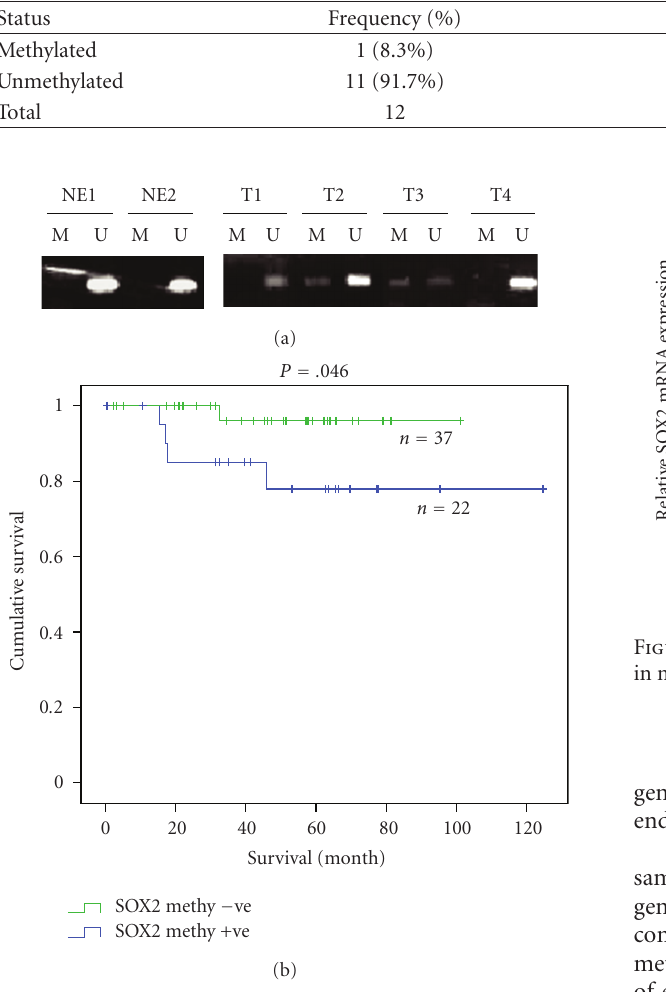
Figure 1: (a) Representative examples of methylation-specific PCR on SOX2 in endometrial carcinomas (T), and in normal endome- trial tissue (NE), demonstrating methylated (M) and unmethylated (U) alleles. (b) Survival curves of patients classified according to the presence or absence of methylated SOX2 allele.